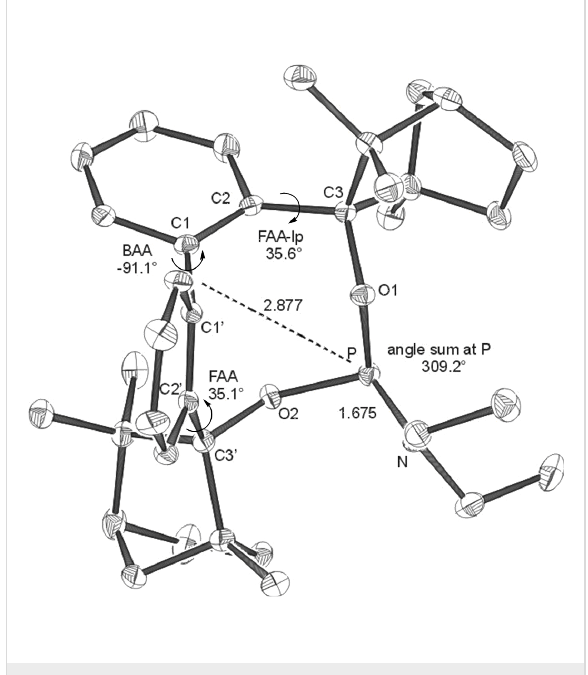
Figure 7: X-ray structures of phosphoramidite BIFOP-NEt2 ( 7 ). Distances are given in Å. (BAA = biaryl angle between C 2 -C 1 -C 1 '-C 1 '; FAA-lp = fenchyl-aryl dihedral angle between C 1 -C 2 -C 3 -O 1 ; FAA = fenchyl-aryl dihedral angle between C 1 '-C 2 '-C 3 '-O 2 ). The probability of ellipsoids is 40% (CCDC 270536).